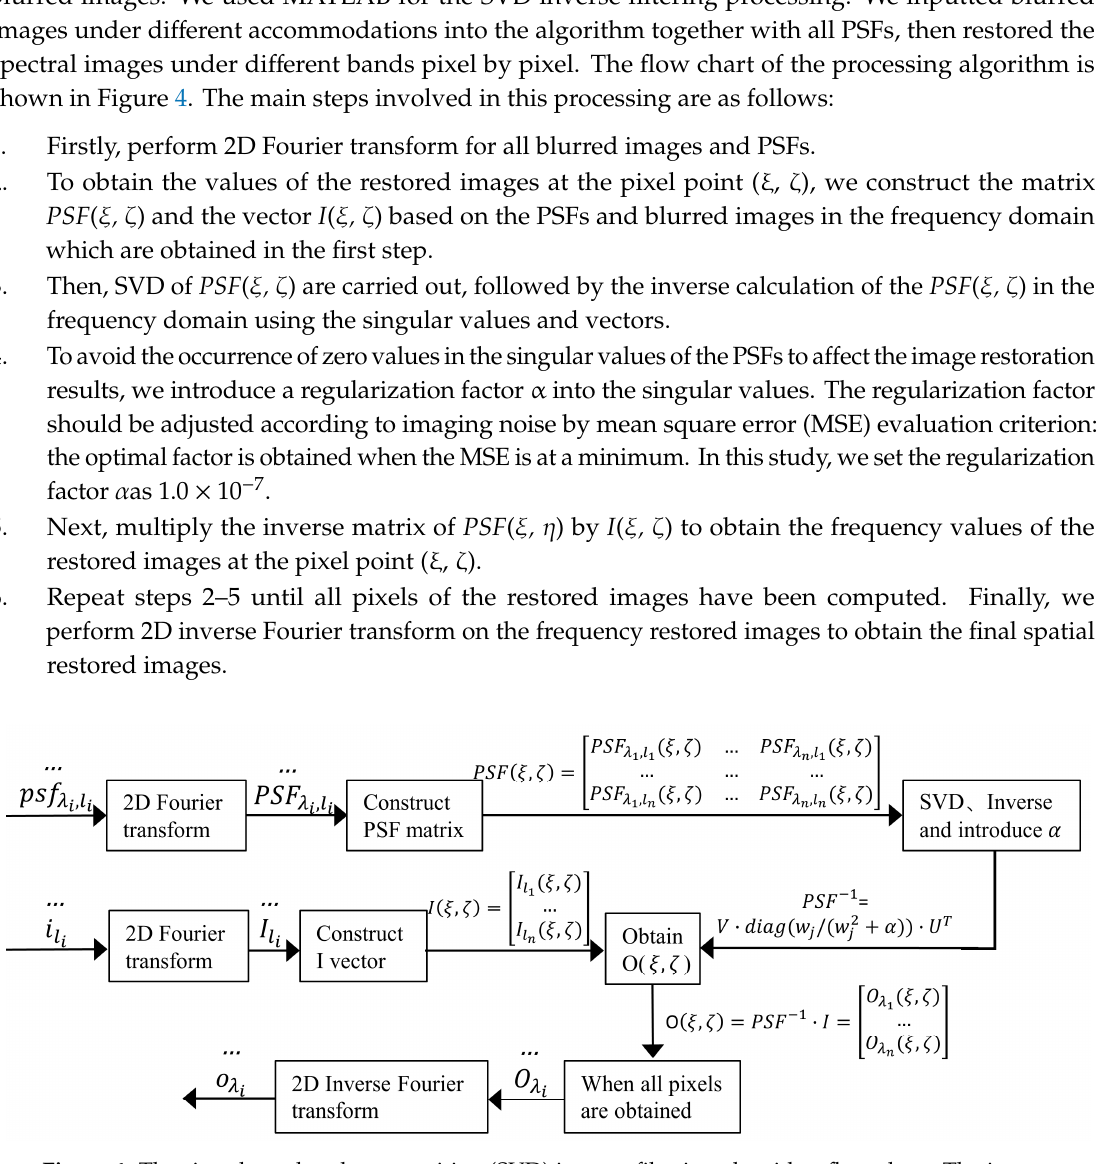
Figure 4. The singular value decomposition (SVD) inverse filtering algorithm flow chart. The input data are chromatically blurred images and PSFs of the octopus eye optical system, the outputs are restored spectral images of the target.